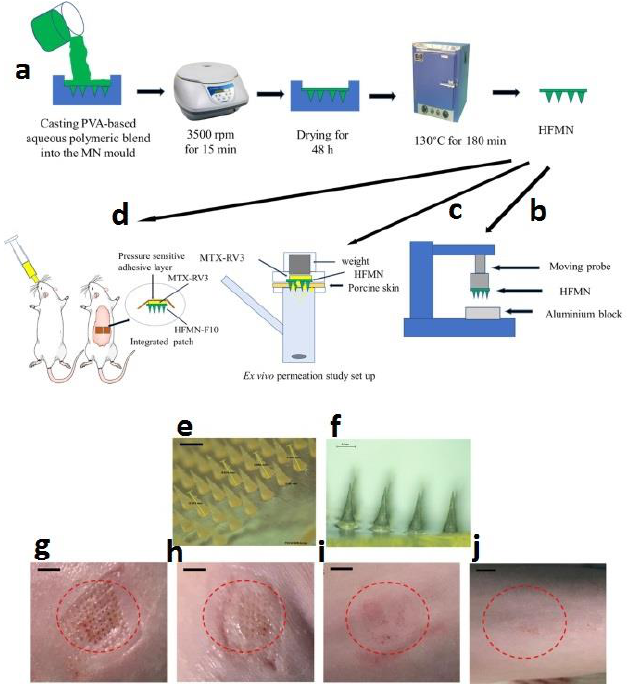
Figure 1. ( a ) Schematic representation of preparation procedures for hydrogel-forming microneedle arrays (HFMN). PVA-based polymeric blends (green) and MTX (yellow). ( b ) Experimental setup for measuring the mechanical strength of HFMN. ( c ) Schematic diagram for the experimental setup for the ex vivo permeation studies. ( d ) The experimental setup for the in vivo study, where two integrated patches were applied to the back of the rat and MTX aqueous solution administered orally. ( e ) Microscopic images of HFMN-F10 before insertion into skin, the black scale bar represents a length of 0.5 mm. ( f ) Swollen intact HFMN-F10 after removing from rats skin following 24 h application. ( g ) Digital images showing the micro holes created by HFMN in rats skin immediately after HFMN removal and that no irritation at the application site but only mild erythema. ( h ) The microholes visibly closed after 30 min from removing the HFMN. ( i ) The microholes cannot be identified visibly after 2 h from removing the HFMN. ( j ) No sign of infection (redness, swelling, pus, oozing or weeping) at the application site even after 24 from removing the HFMN. [74]. Reprinted with the permission from International Journal of Pharmaceutics. Copyright Elsevier,